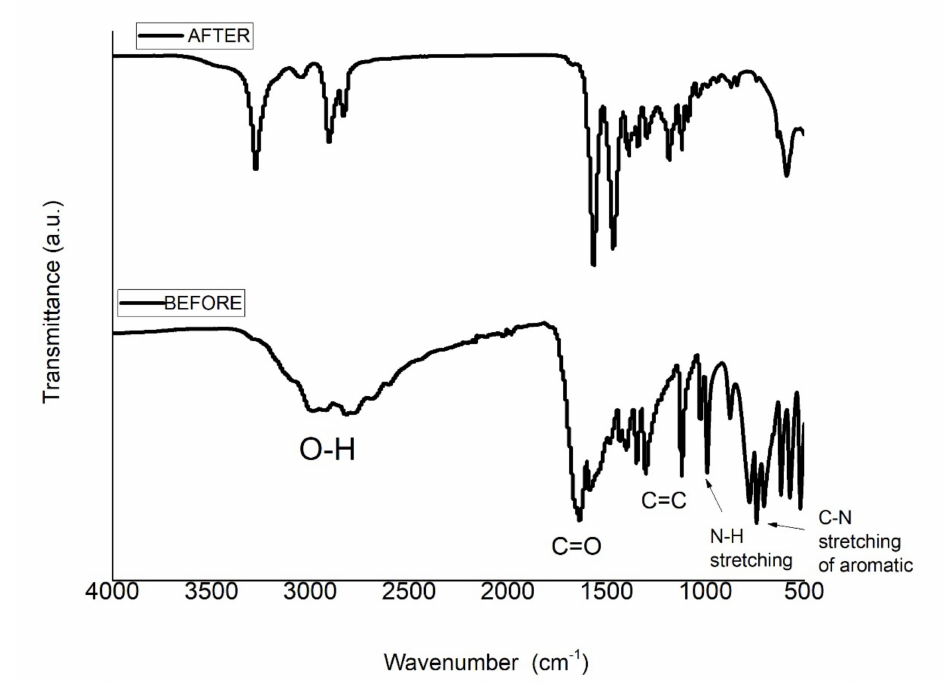
Figure 10. FTIR spectra of the NY6 / MCB60-1.0 before and after uric acid